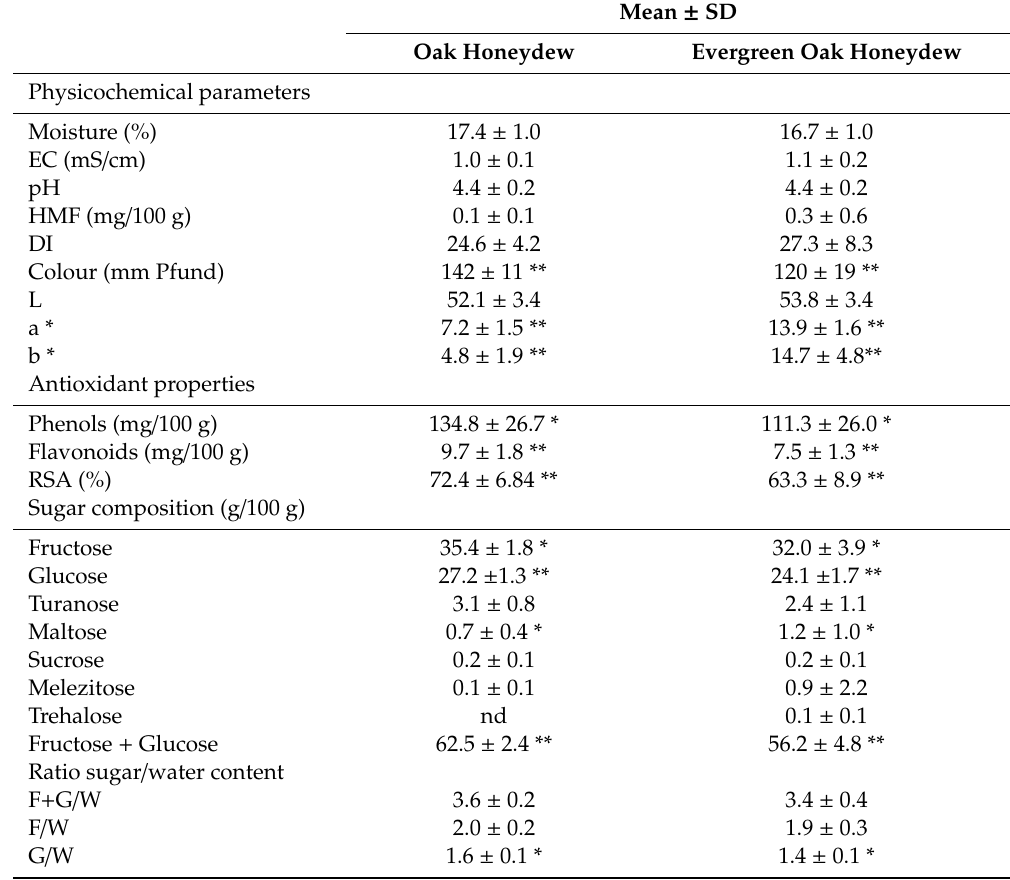
Table 3. Multiple-Sample comparison between both honey types by Fisher’s least significant di ff erence